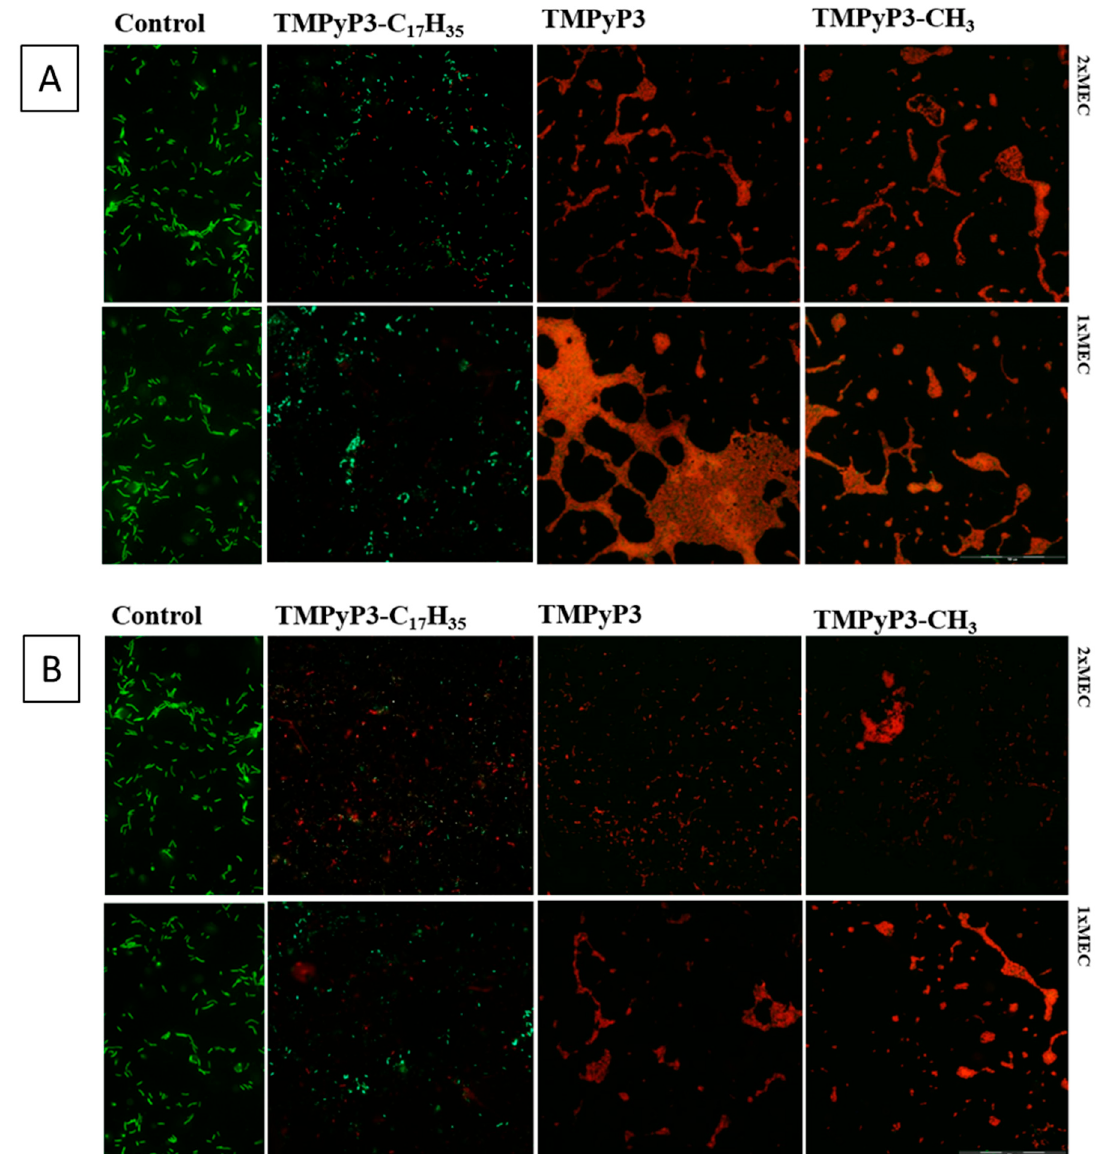
Figure 4. Changes in membrane permeability, observed under fluorescent microscope. Legionella pneumophila was treated with PSs of 1 × MEC and 2 × MEC concentrations and after 30 min incubation protected from light, illuminated with violet light for 10 min ( A ) and 30 min ( B ) (total light dose 12 J / cm 2 and 36 J / cm 2 , respectively). Membrane permeability was tested using Dead Live staining. Green fluorescence is representing an intact membrane, and red fluorescence indicates a permeable membrane. Scale bars correspond to 50 µm.